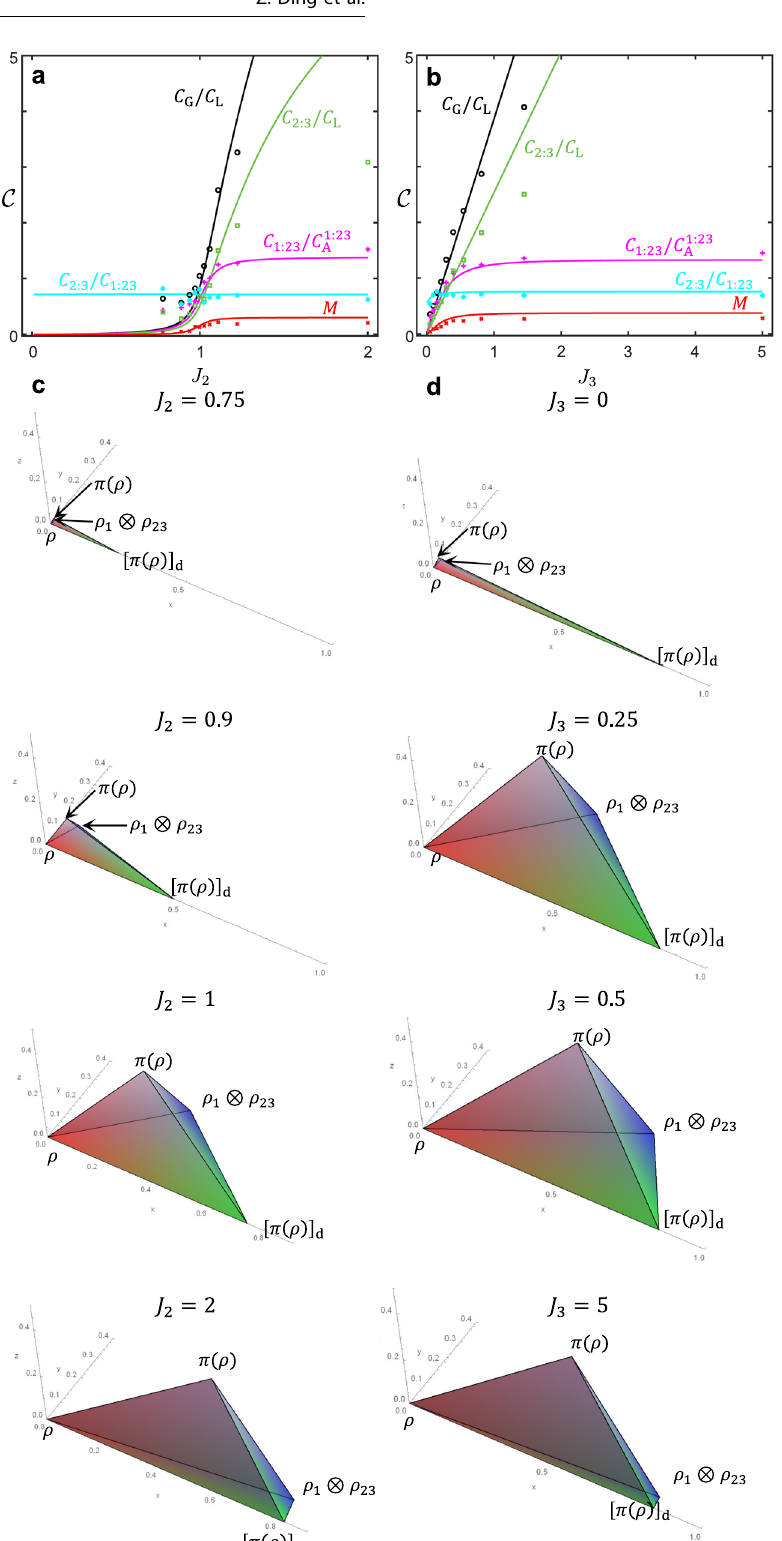
Fig. 3 Visualization of the trade-off relations. The ratio between the different pairs of coherences and monogamy of coherence is shown in a Hamiltonian H zz and b Hamiltonian H zzz as a function of interaction parameters. The points represent the experimental data and the solid lines correspond to the theoretical calculation. c , d Geometric plots of the coherence in three-dimensional Euclidean space for the H zz and H zzz , respectively, for the values of interaction parameters as marked (top to bottom). The lengths of the edges are taken to be the coherence contributions as shown in Fig. 1b. The coordinates of the state ρ are (0, 0, 0); [ π ( ρ )] d is ðC A ; 0 ; 0 Þ ; π ( ρ ) is ðC G cos θ ; C G sin θ ; 0 Þ ; ρ 1 ⊗ ρ 12 is ϕ ; C ϕ cos ξ ; C ϕ sin ξ Þ , where the angles are chosen to match the coherences as in Fig. ðC 1 : 23 cos 1 : 23 sin 1 : 23 sin